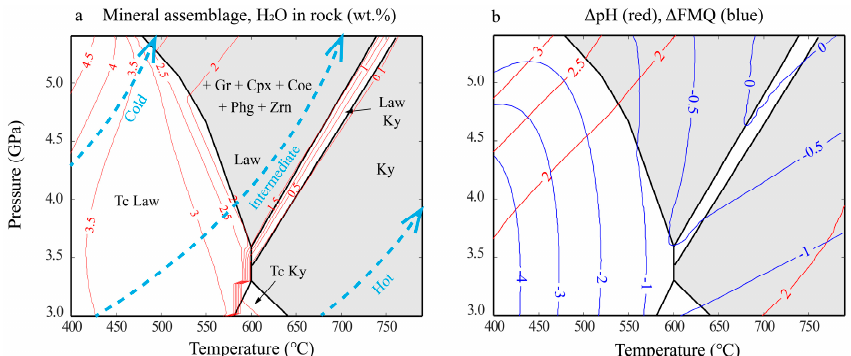
Figure 1. Results of thermodynamic simulation using the NaCl-absent fluid. ( a ) P-T pseudosection showing mineral assemblages and contents of lithological bound water in eclogite metamorphosed from altered oceanic basalt. The geotherms of hot, intermediate and cold subduction zones are for slab Moho, from van Keken et al. [39]. ( b ) The acidity ( ∆ pH, red dashed lines with labels) and redox ( Δ FMQ, blue) of the rock-buffered fluid. Δ pH is the deviation from neutral pH (pH n ) ( Δ pH = pH − pH n ), and Δ FMQ is the difference in log f O 2 (g) of the fluid relative to the fayalite-magnetite-quartz (FMQ) buffer ( Δ FMQ = log f O2, fluid − log f O2, FMQ ). The bulk rock composition is given in Table 1. Mineral abbreviations: Cpx = clinopyroxene; Gr = garnet; Coe = coesite; Law = lawsonite; Tc = talc; Ky = kyanite; Phg = phengite; Zrn = zircon.